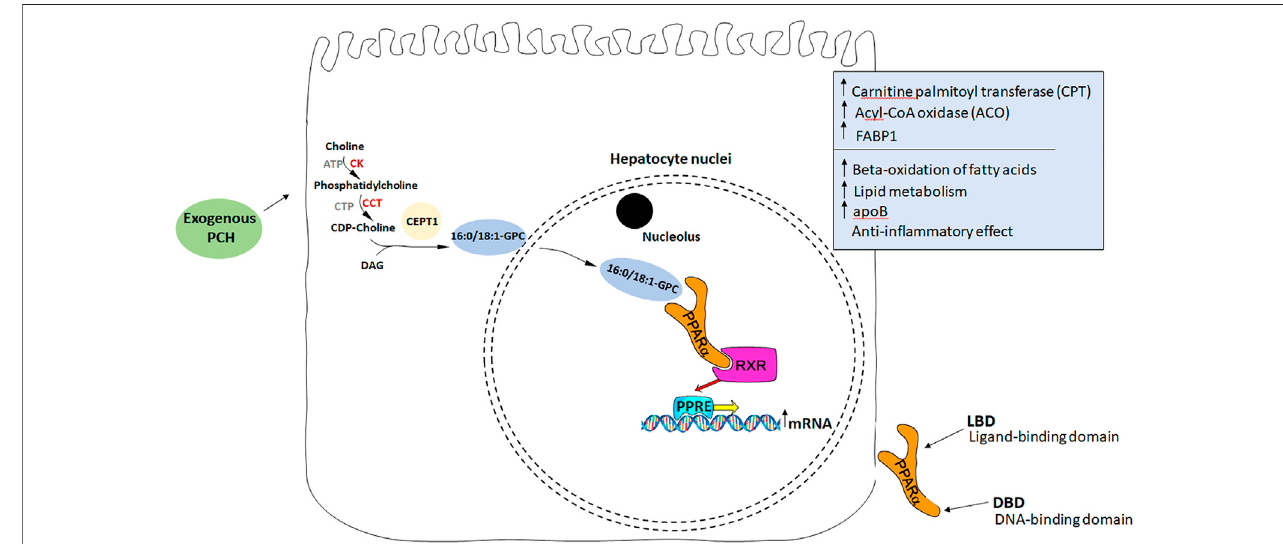
FIGURE 2 | PCH as an endogenous ligand of PPAR α . Exogenous PCH means PCH administered with essential phospholipids. (1) PCH stimulates endogenous synthesisof16:0/18:1-GPCbindingwithPPAR α receptors.(2)AfterPPAR α activationitbindstoanothertranscriptionfactor,RXR(retinoid-xreceptor).(3)Theformation of heterodimeric complexes leads to their transport into the nucleus. (4) Heterodimeric complexes bind to the speci fi c sequence, peroxisome proliferator response element(PPRE),localizedinthepromotersofdifferentgenesresponsibleforACO,CPT,andFABP1synthesis.(5)*Acyl-CoAoxidaseparticipatesintheoxidationof fattyacids.*CarnitinepalmitoyltransferaseisresponsibleforthetransferofFAfromtheoutertotheinnermembraneforoxidationofthefattyacidinsidethemitochondria. *FABP1 provides an appropriate VLDLs